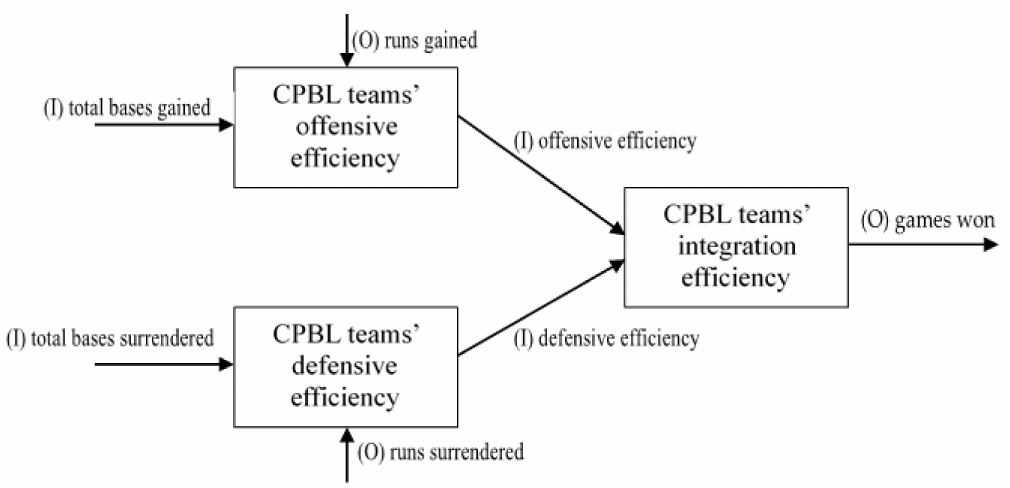
Figure 4. System analysis model for the competition e ffi ciency of CPBL